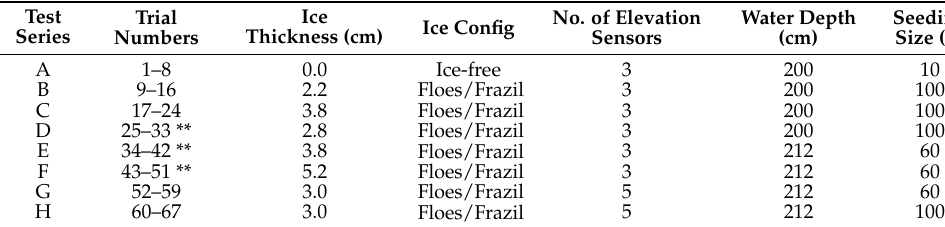
Table 1. Wavemaker settings for the 8 trials of each test series (period, height). Table 2. Experiment details.